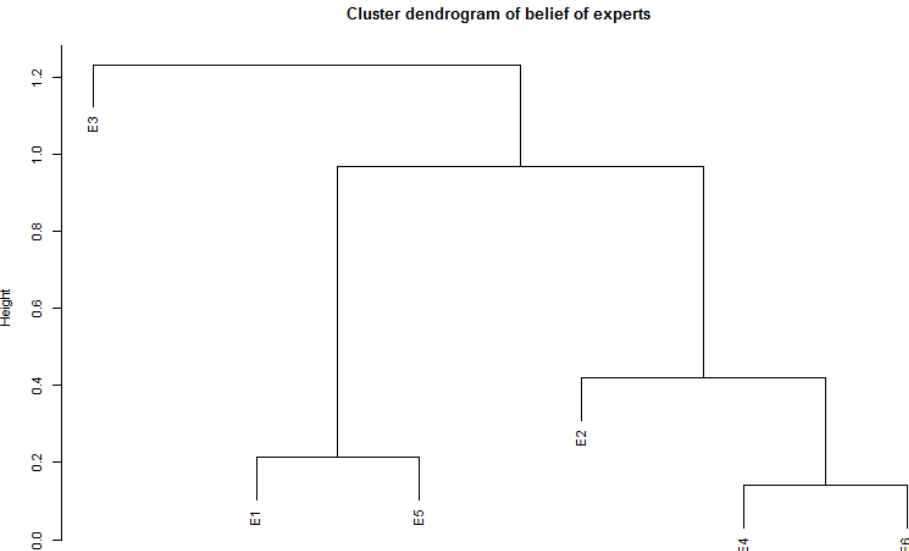
Figure 8. Cluster dendrogram of the six